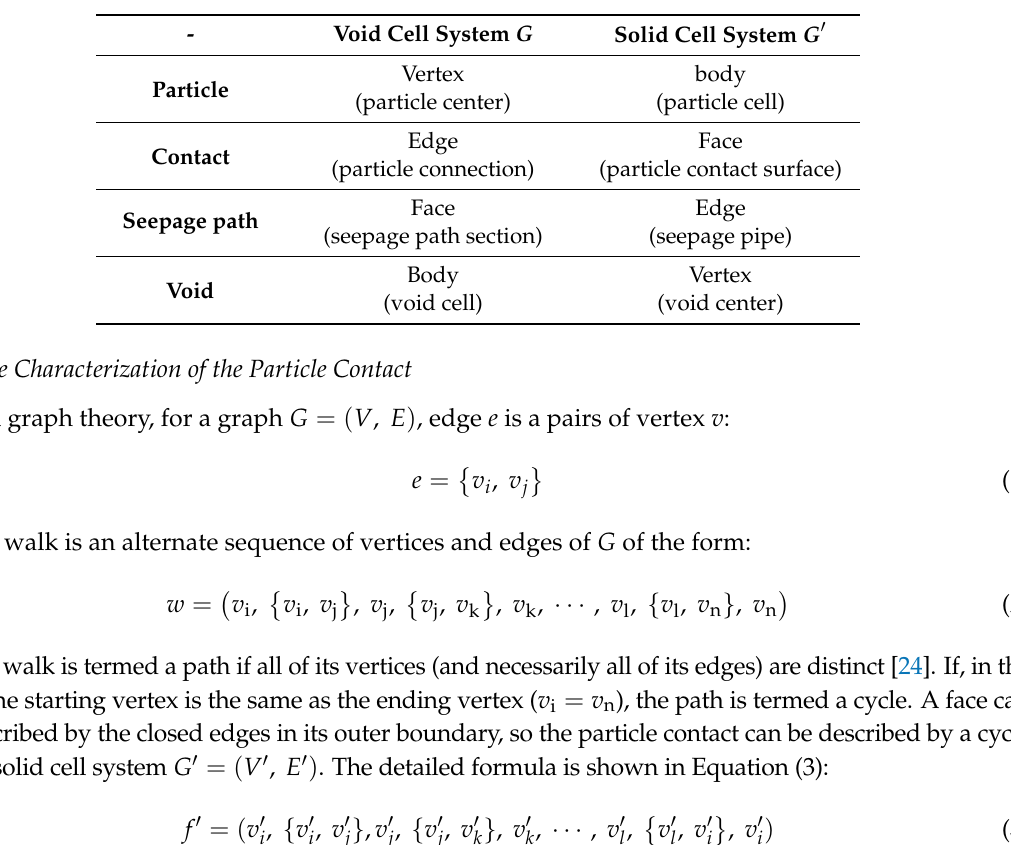
Table 1. The correspondence between the composition of the granular material and the elements of the two dual geometric